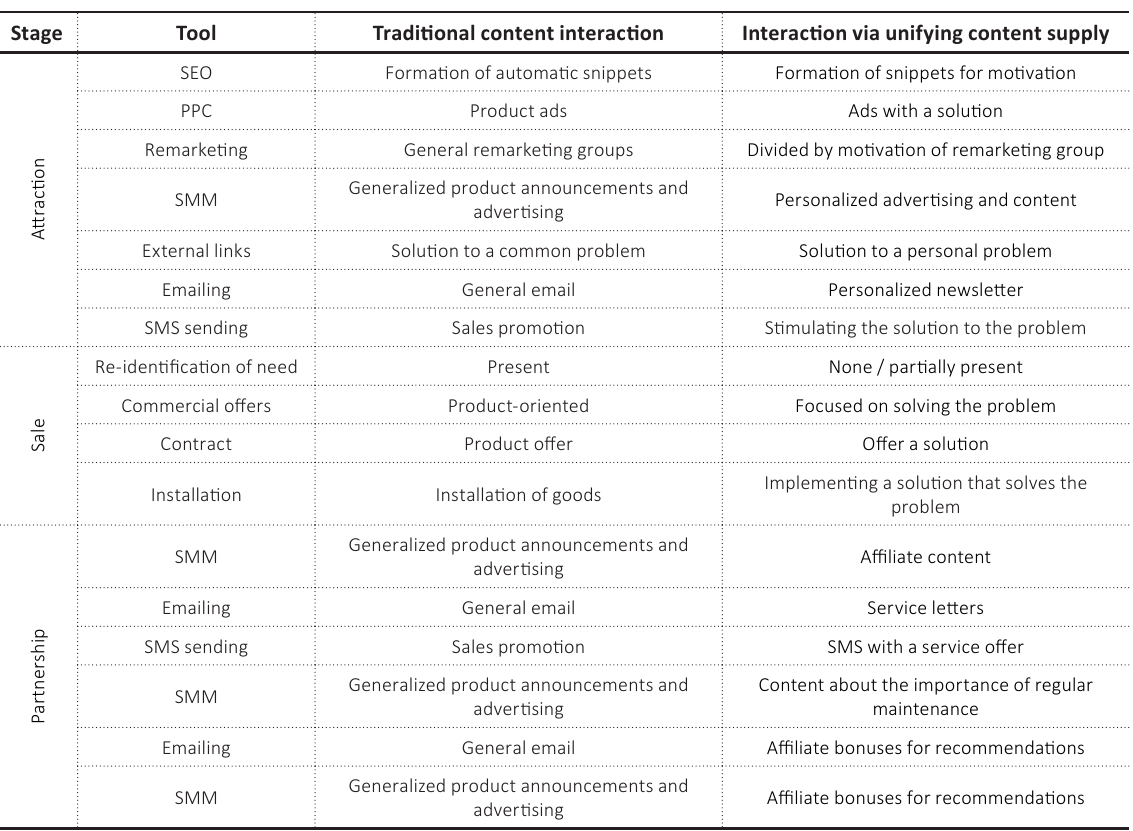
Table 3. Differences between traditional content interaction and interaction via unifying content